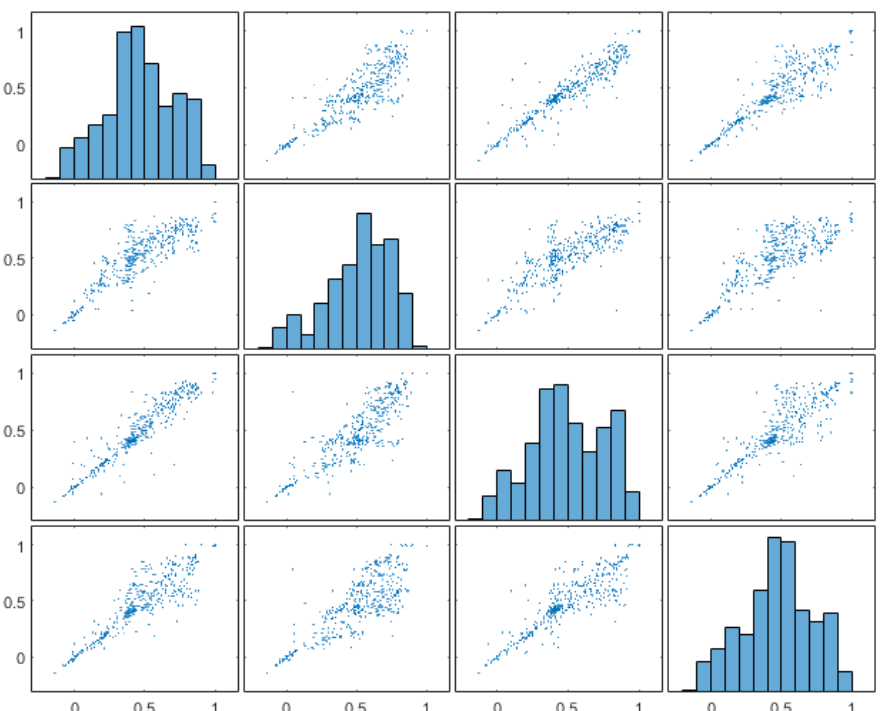
Figure 10. ( Top ) Plot matrix of the NDVI values of the four areas of interest over the Csanádpalota ‐ Juhász T. tanya site. The X ‐ axis corresponds to the selected area, while Y ‐ axis corresponds to each one of the four areas. ( Bottom ) Plot matrix as before using the ARVI index.